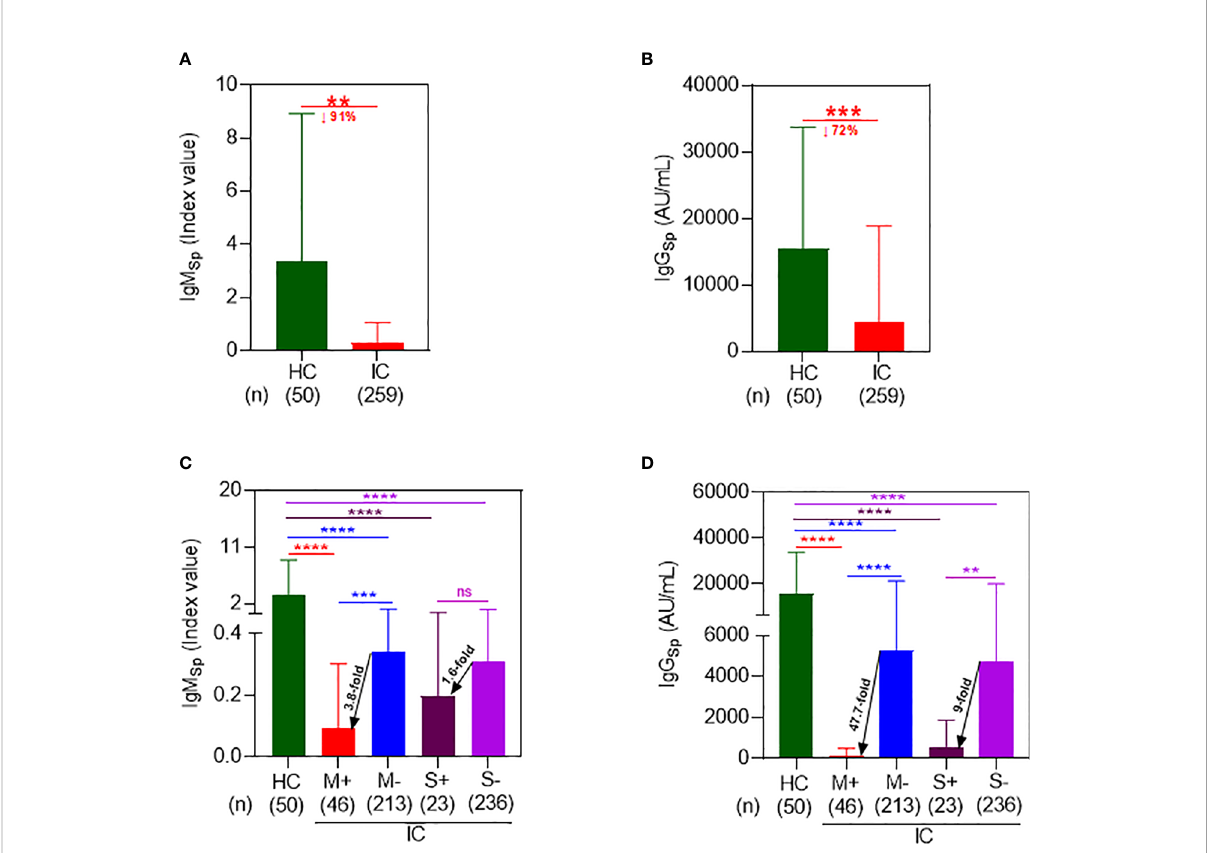
FIGURE 1 Immunocompromised patients on mycophenolate and sirolimus evoked a poor spike antibody response following 2D Co-mV administration. (A) Changes in IgM Sp antibody (index value) levels following administration of 2D of Co-mV administration in HC subjects and IC patients receiving routine ISs combination that included mycophenolate and sirolimus. (B) Comparison of IgG Sp (AU/mL) levels in 2D Co-mV- administered IC patients maintained on routine ISs combination that included mycophenolate and sirolimus with immunocompetent HC subjects. (C) IgM Sp antibody concentrations among HC and different IC patient groups categorized based on the presence and absence of mycophenolate and sirolimus on their ISs regimen. (D) Quanti fi cation of IgG Sp in HC subjects and IC participants receiving or not receiving mycophenolate and sirolimus as part of their immunomodulatory therapy after 2D Co-mV immunization. In panels (A – D) , the box plot indicates mean ± SD. For the panels (A, B) , comparison of the means among the groups and the statistical difference was established using two-tailed Welch ’ s t-test and for panels (C, D) , using Kruskal-Wallis One-Way ANOVA. In panels (A – D) , the signi fi cant interaction denotes the following: (** p = 0.0003; *** p = 0.0001; **** p < 0.0001 vs the respective compared group, as indicated). 2D, two doses; Co-mV, COVID-19 mRNA vaccines; HC, healthy controls; IC, immunocompromised; ISs, immunosuppressants; Sp, spike; IgM, immunoglobulin M; IgG, immunoglobulin G; AU, arbitrary units; SD, standard deviation; ANOVA, analysis of variance; ↓ , decrease; M+, receiving mycophenolate along with other ISs; M-, not receiving mycophenolate alone; S+, receiving sirolimus along with other ISs; S-, not receiving sirolimus